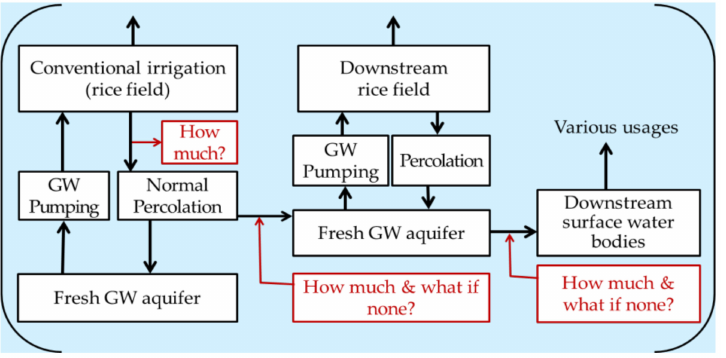
Figure 3. The pathways of the components of water from a rice field under conventional irrigation with